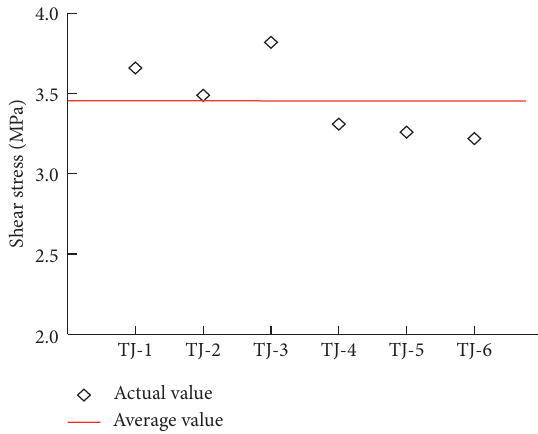
Figure 5: The direct shear strength and average value of rock fractures ( σ �